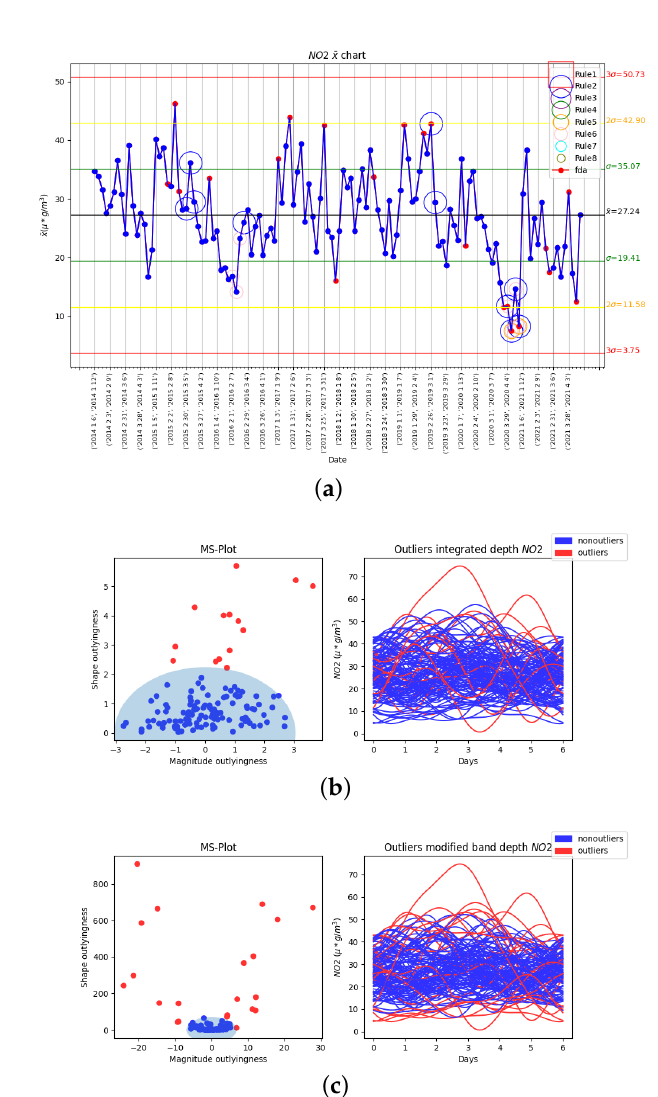
Figure 4. Results of the third phase of the NO 2 analysis: ( a ) ¯ x chart with the weekly rational subgroups of the first four months of every year, the Nelson rules implemented, and the functional outliers detected with the modified band depth marked with red dots; ( b ) (left) Cartesian representation of the magnitude and shape outlyingness of each function with the integrated depth; (right) functional plot of the NO 2 values of each week; ( c ) (left) Cartesian representation of the magnitude and shape outlyingness of each function with the modified band depth; (right) functional plot of the NO 2 values of each